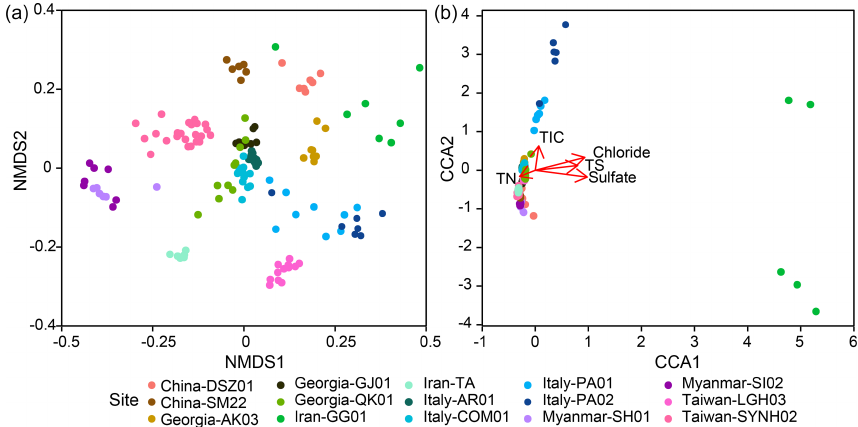
Figure 4. Variance of 16S rRNA community compositions deduced from (a) the NMDS analysis based on the Bray–Curtis distance and (b) the CCA analysis based on the chi-square distance. Ordination of significant geochemical parameters was overlaid for comparison in panel (b)